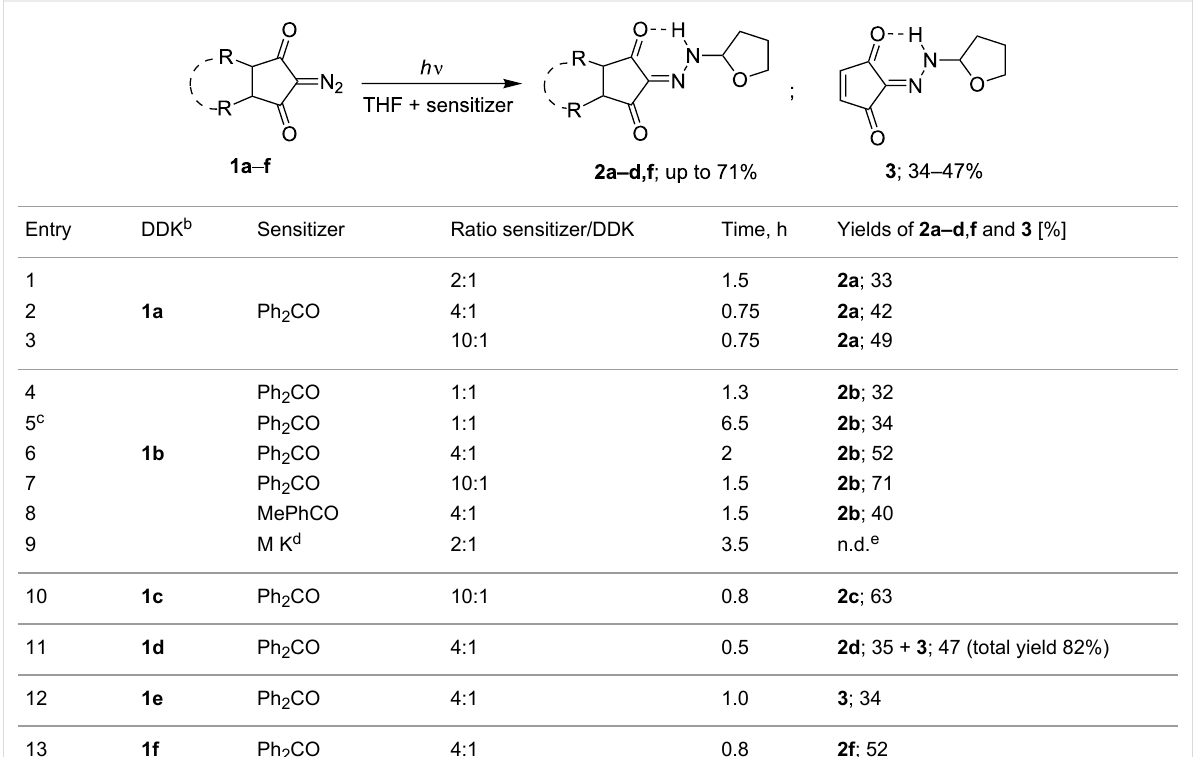
Table 1: Sensitized light-induced reactions of diazodiketones 1 а –f . a